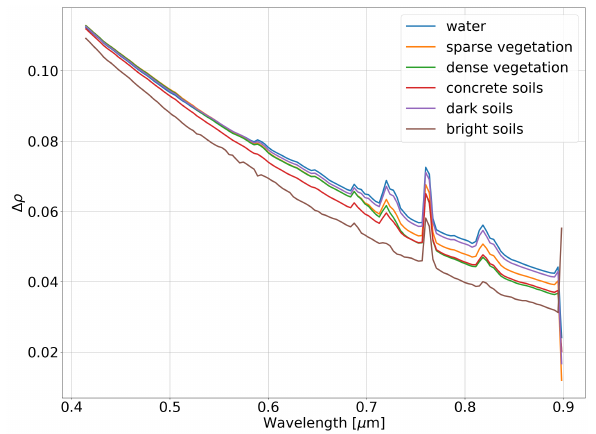
Figure 6. Surface reflectance theoretical error for a 0.15 µ m modal radius plume for different types of ground.